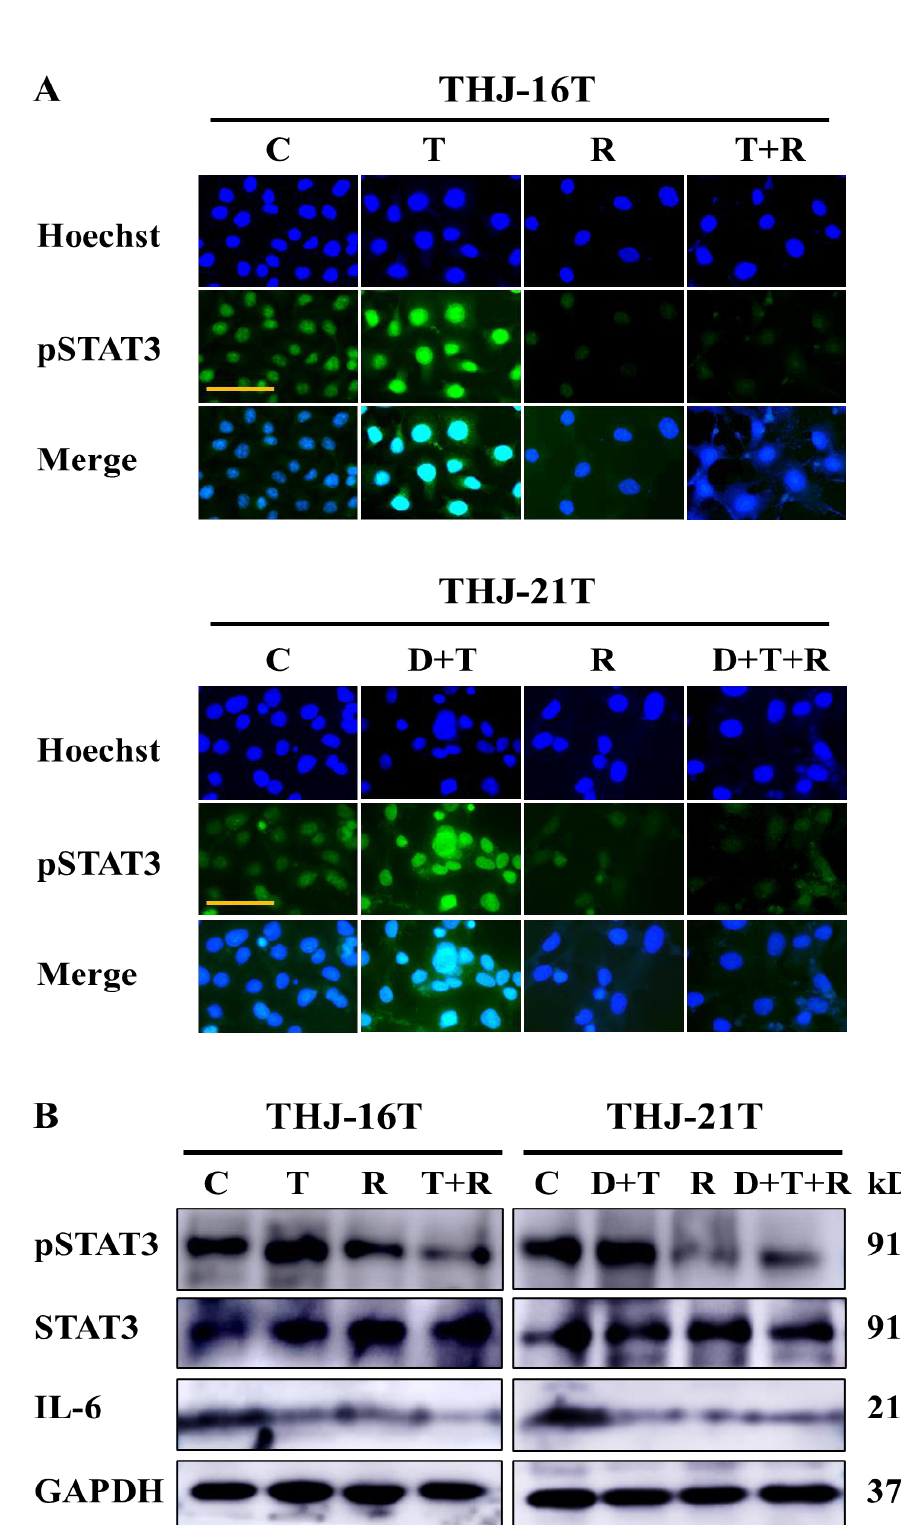
Figure 6. Variable pSTAT3, STAT3, and IL-6 levels in THJ-16T and THJ-21T cells before and after drug treatments. ( A ) Immunofluorescent labeling (scale bar, 50 μ m) of pSTAT3 in THJ-16T and THJ-21T cells. ( B ) Western blotting performed on THJ-16T and THJ-21T cells. GAPDH served as a loading control. C, cultured in 0.2% DMSO containing medium as control; T, trametinib; D, dabrafenib; D+T, dabrafenib and trametinib; R, resveratrol; T+R, trametinib and resveratrol; D+T+R, dabrafenib, trametinib, and